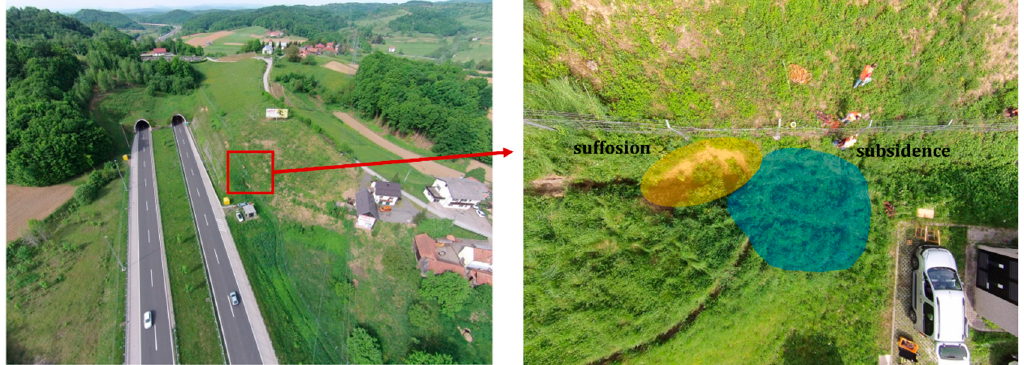
Figure 4. Su ff osion next to the right side lane of Rijeka–Zagreb Figure 4. Suffosion next to the right side lane of Rijeka–Zagreb highway.